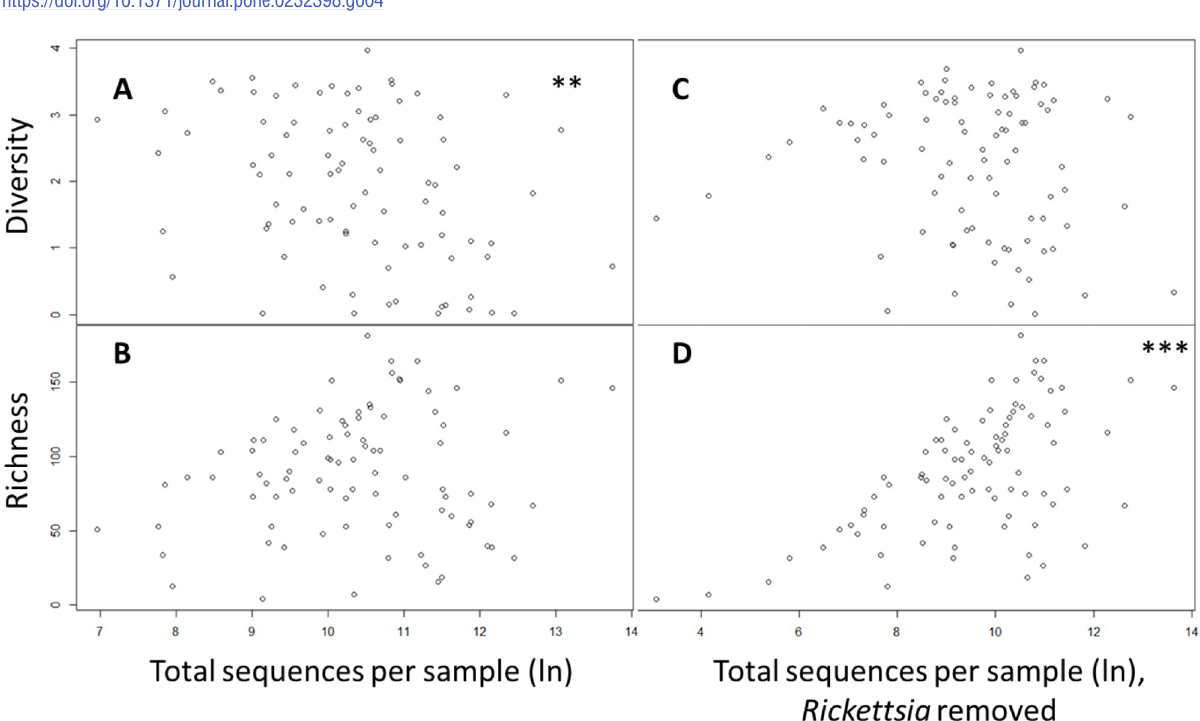
Fig 5. Relationship between sequencing depth per sample and microbial diversity (Shannon’s Index) in ticks with (A) and without (C) Rickettsia included in the analysis. Panels B and D show the relationship between sequencing depth and taxonomic richness with and without Rickettsia , respectively. Asterisks indicate significance at P = 0.01 ( �� ) and P = 0.001 ( ��� ).